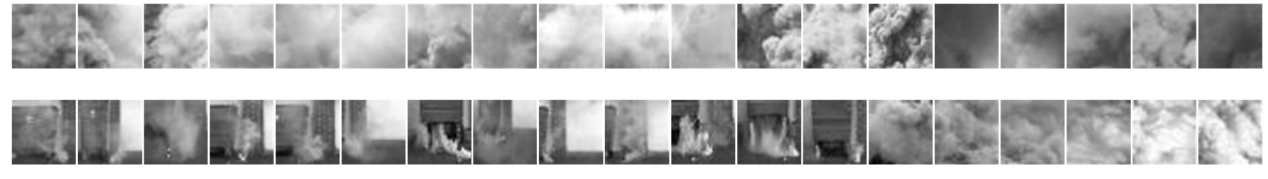
Figure 11. Positive sample examples.